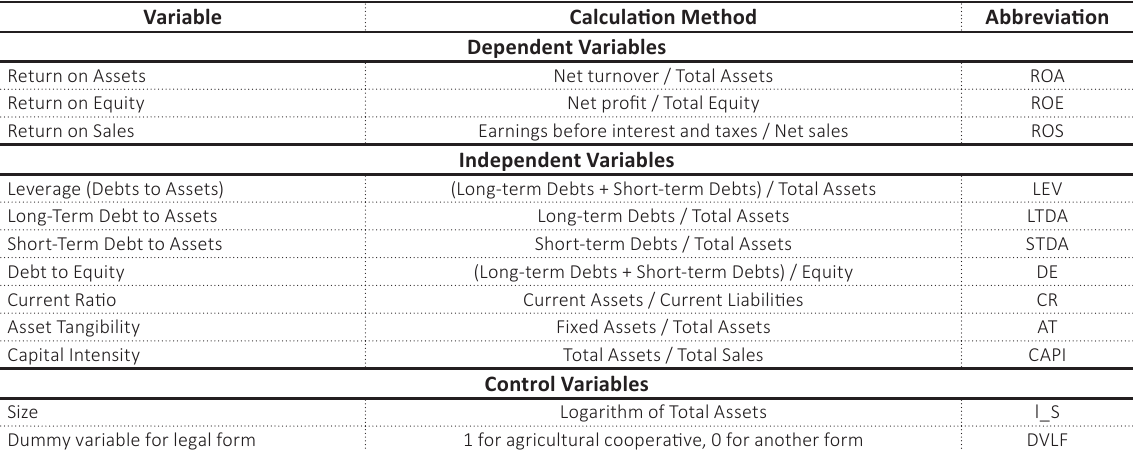
Table 1. Variable definitions, calculation and